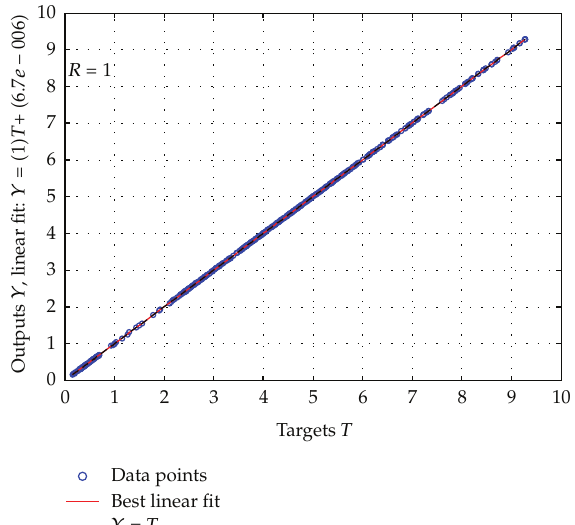
Figure 6: Regression analysis between the ANFIS output and the corresponding